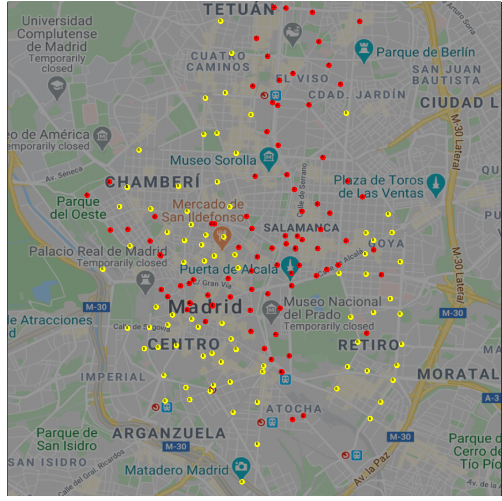
Figure 3. Spatial location of docking stations in clusters A (red) and B (yellow).